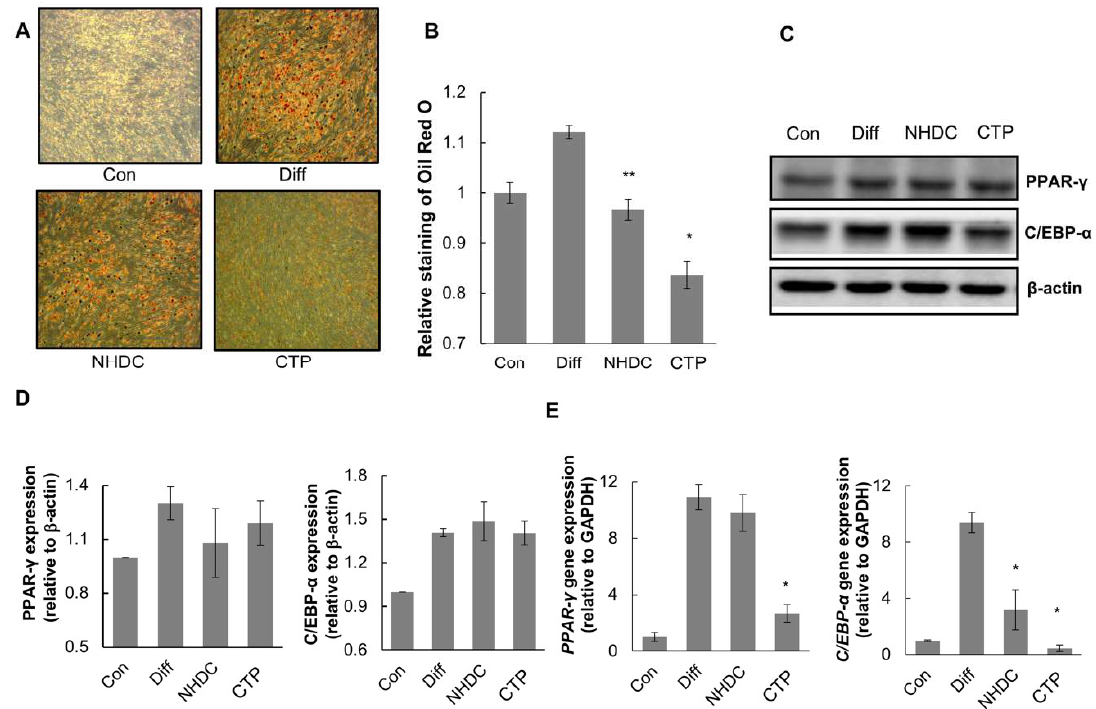
Figure 3. Effect of NHDC and CTP on adipogenic differentiation. Cells were seeded on 12-well plate and cultured for 14 days with or without differentiation medium and compounds. 14 days after culturing in adipogenic differentiation medium or Differentiated hASCs were stained with Oil Red O as described in Materials and Methods ( A ). Lipid accumulation was quantified by Oil Red O uptake and the amount of eluted dye was measured at the absorbance of 510 nm ( B ). Through Western Blotting assay of PPAR- γ and C/EBP- α ( C ) and its quantification, Bands’ densities were analyzed by using ImageJ software (http://rsbweb.nih.gov/ij) ( D ). Quantitative RT-PCR results of PPAR- γ and C/EBP- α were evaluated ( E ). The results are expressed as the mean values ± SD ( n = 3); * p < 0.01, ** p < 0.05 as compared to the differentiation group. Con, control group cultured in growth medium only; Diff, differentiation group cultured in adipogenic differentiation medium.